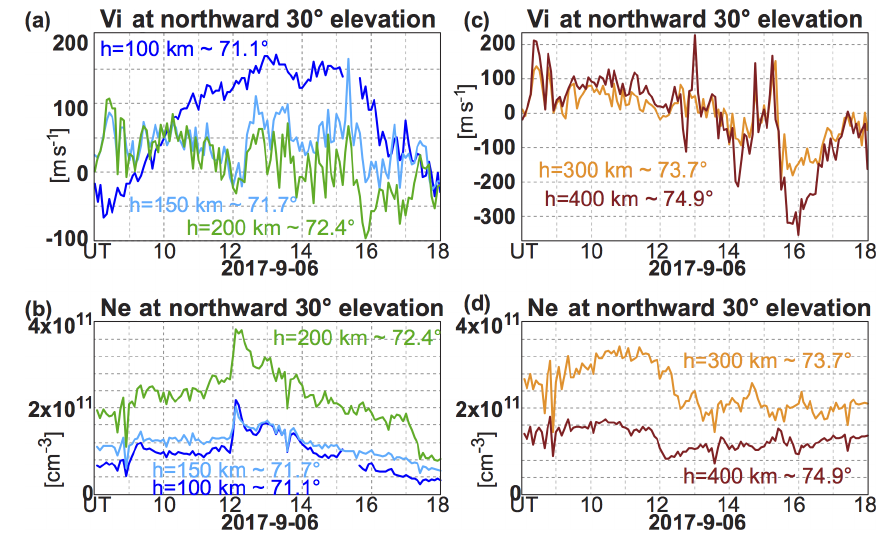
Figure 5. Ionospheric line-of-sight ion velocity and electron density observed by EISCAT Tromsø VHF (224MHz) radar from 69 ◦ GGlat, looking northward at its lowest elevation angle (30 ◦ ) above the horizon. Panels (a) and (c) show the ion velocity, and panels (b) and (d) show the electron density.